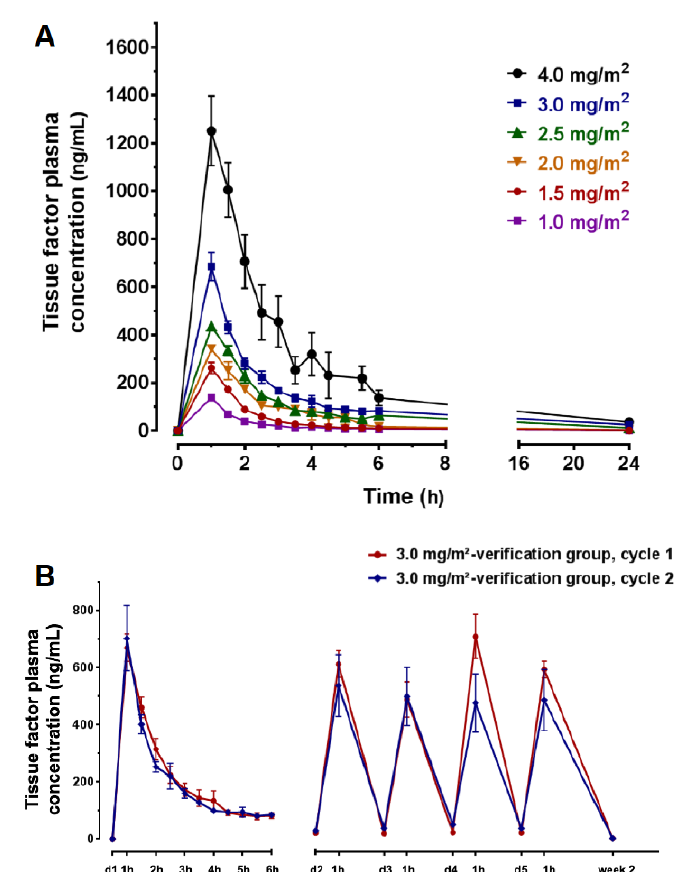
Figure 7. Pharmacokinetics with plasma concentration—time curves of tTF-NGR for different doses applied: ( A ) Cmax values at the end of infusion (1 h) and dose-time curves when 1–4 mg/m 2 tTF-NGR were given over 1 h on day 1 (0–24 h). Interpretation of pharmacokinetic (PK) values at 5 mg/m 2 dose